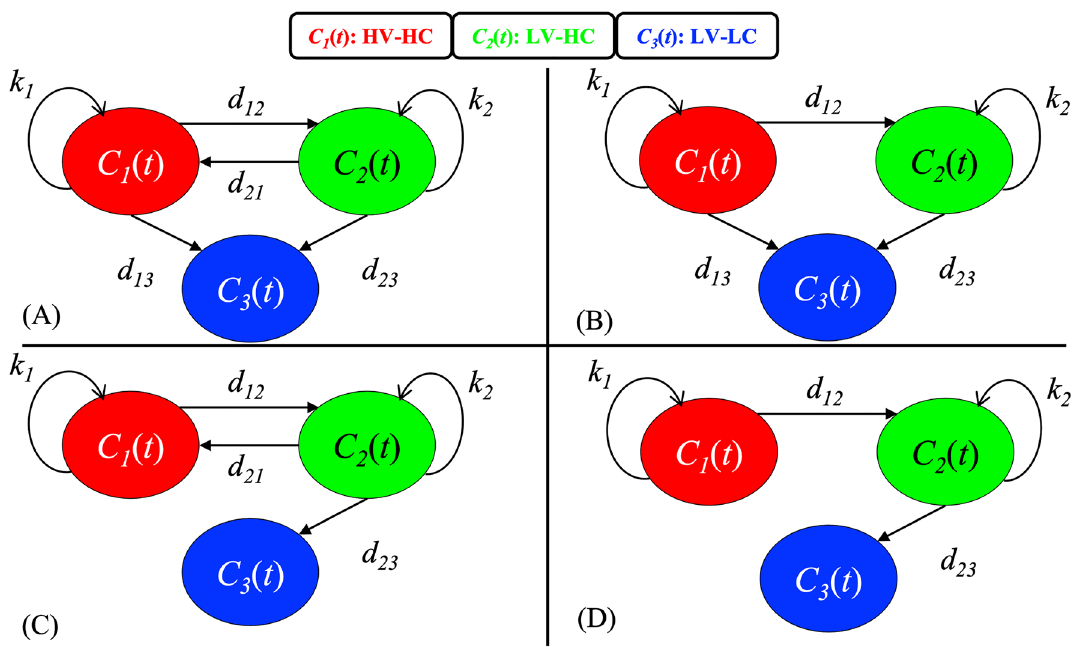
Figure 2. Visualizing a three-compartment mathematical model of tumor habitat growth. ( A - D ) correspond to Models ( A - D ), respectively, as introduced in Methods “The mathematical model family” section. In all panels, C 1 ( t ) corresponds to the HV-HC habitat (red), C 2 ( t ) corresponds to the LV-HC habitat (green), and C 3 ( t ) corresponds to the LV-LC habitat (blue). The parameters k 1 and k 2 are the growth rates of C 1 ( t ) and C 2 ( t ), respectively, while all parameters of the form d nm dnm represent the transition rate from cluster n to cluster m . All model parameters are named and described in Table